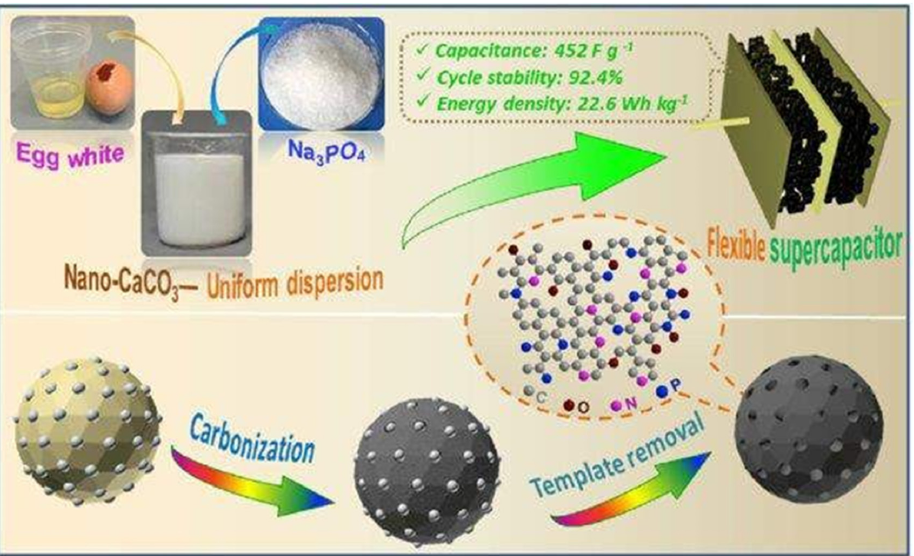
Figure 26. A schematic approach for synthesizing multi-heteroatom co-doped porous carbon for energy storage. Reproduced with permission from [107].